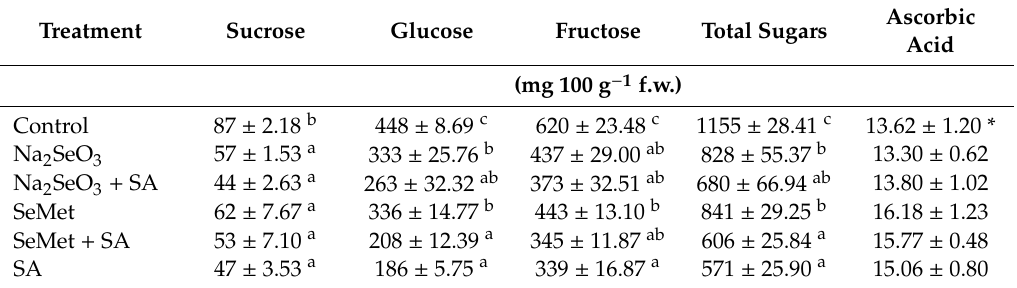
Table 3. The content of ascorbic acid, sucrose, glucose, fructose, and total sugars in lettuce leaves. Treatment Sucrose Glucose Fructose Total Sugars